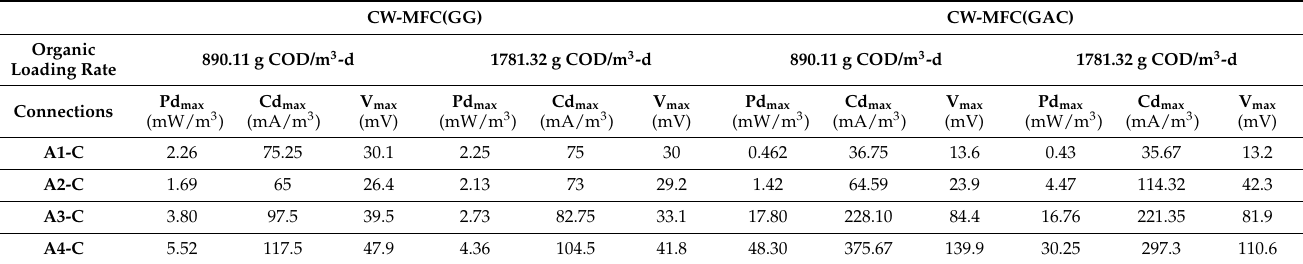
Table 1. Showing maximum voltage (V max ), power density (Pd max ), and current density (Cd max ) under both organic loading